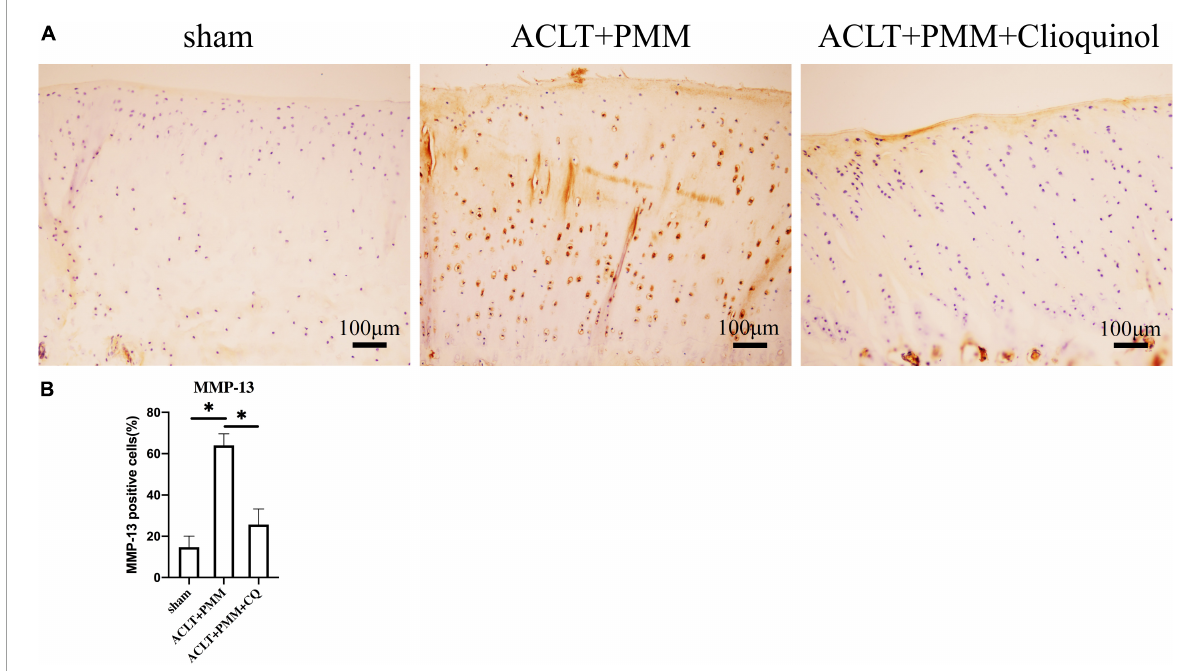
FIGURE5 The change of MMP-13 expression in cartilage after intra-articular injection of clioquinol. (A) Representative IHC staining showing the expression and distribution of MMP-13 in cartilage. (B) Quantitation of ICH staining. All data are shown as the mean ± SD. ∗ p <